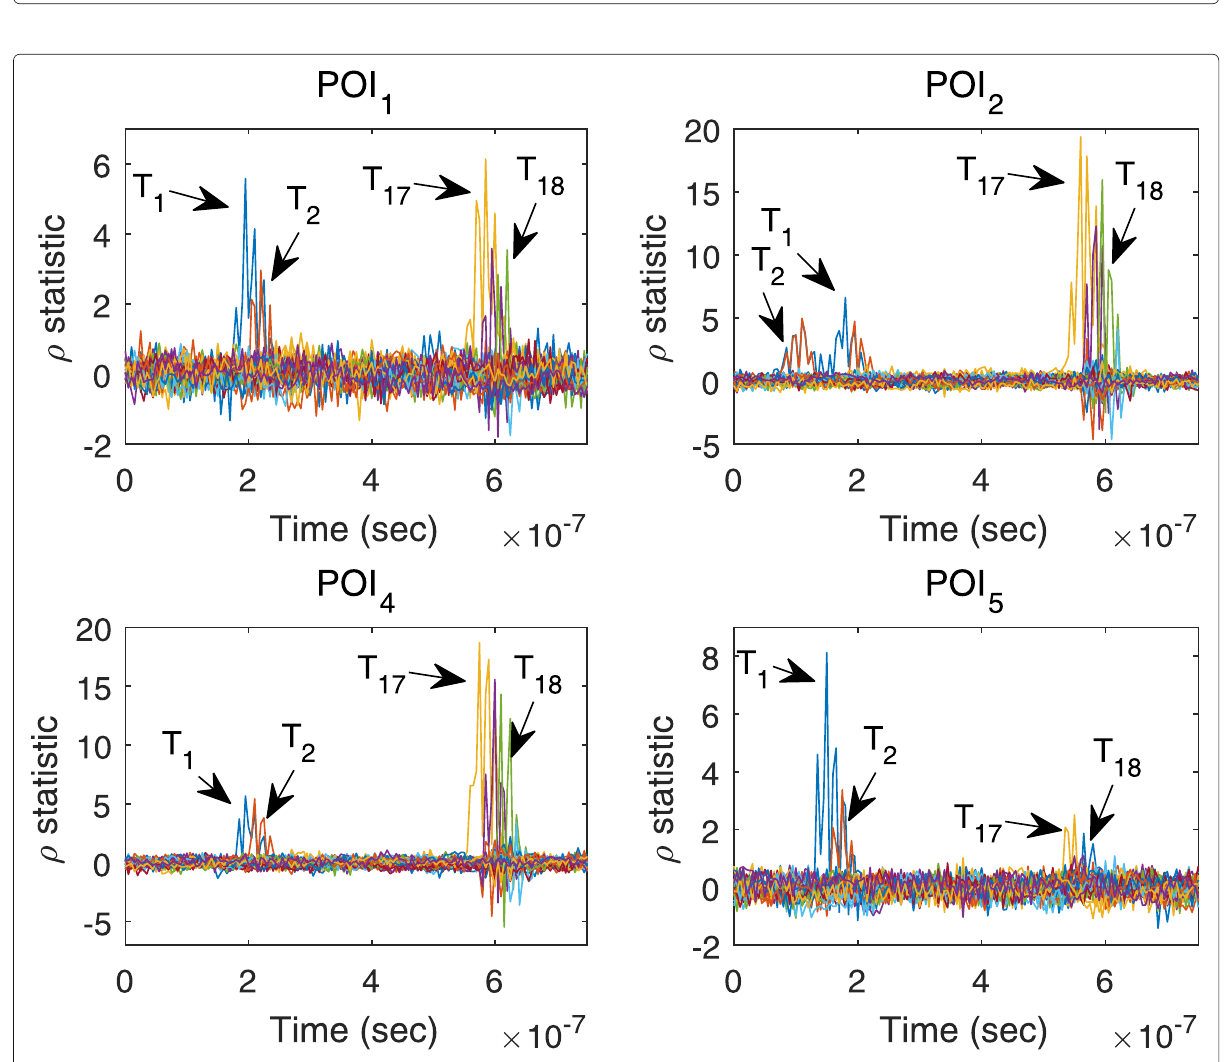
Fig. 11 The experimental results when zooming in POI 1 , POI 2 , POI 4 and POI 5 . T 1 , T 2 , T 17 and T 18 represent the POIs from the 1st, 2nd, 17th and 18th thread within a warp,